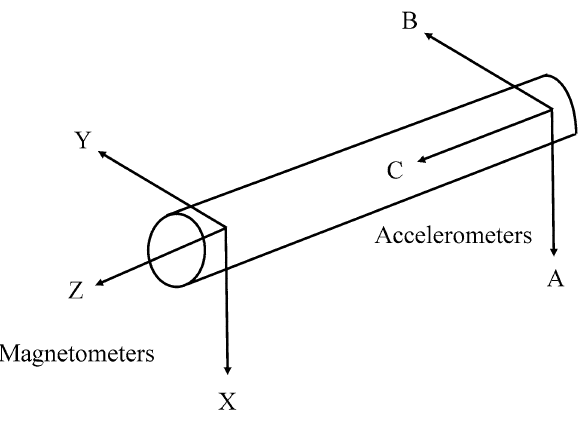
Fig. 2 Measurement while drilling sensor and it